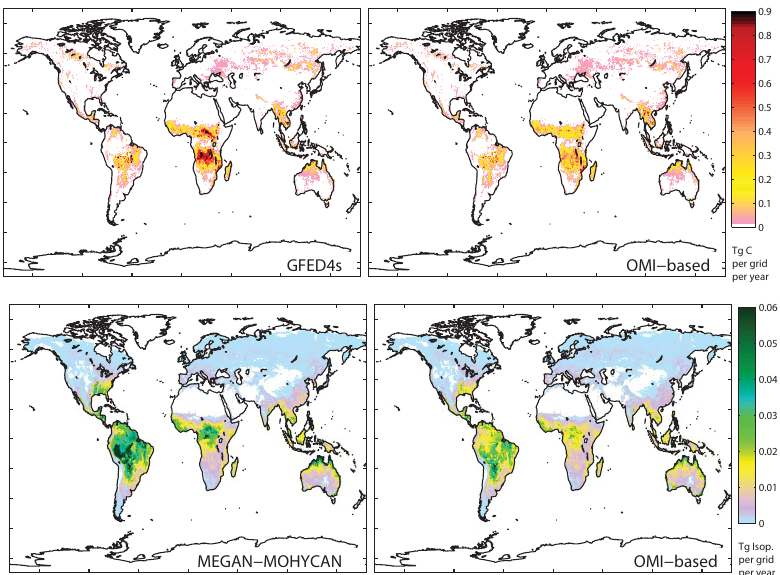
Figure 2. Upper panel: mean (2005–2013) annual biomass burning emission estimates in Tg C/grid per year according to the a priori inventory GFED4s and to the OMI-based biomass burning emissions. Lower panel: mean (2005–2013) annual isoprene emission estimates in Tg isoprene per grid cell per year according to the a priori MEGAN-MOHYCAN inventory and from the OMI-based